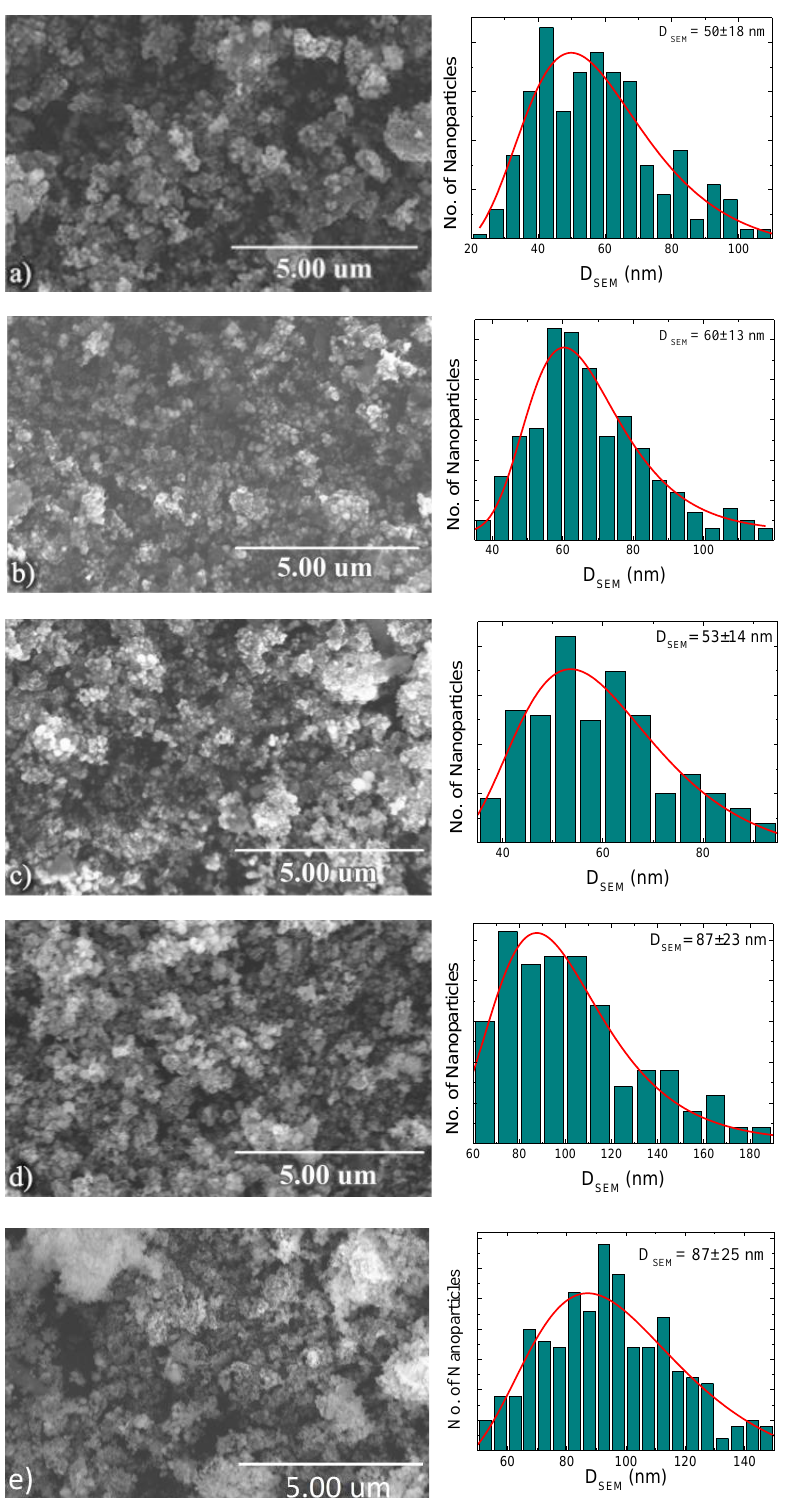
Figure 1. SEM and size distribution of Ni x Cu 4 − x nanoparticles (measured from SEM images) annealed at 300 ◦ C for: ( a ) 0 h, ( b ) 1 h, ( c ) 3 h, ( d ) 6 h, and ( e ) 10 h. Scale bar = 5 µ